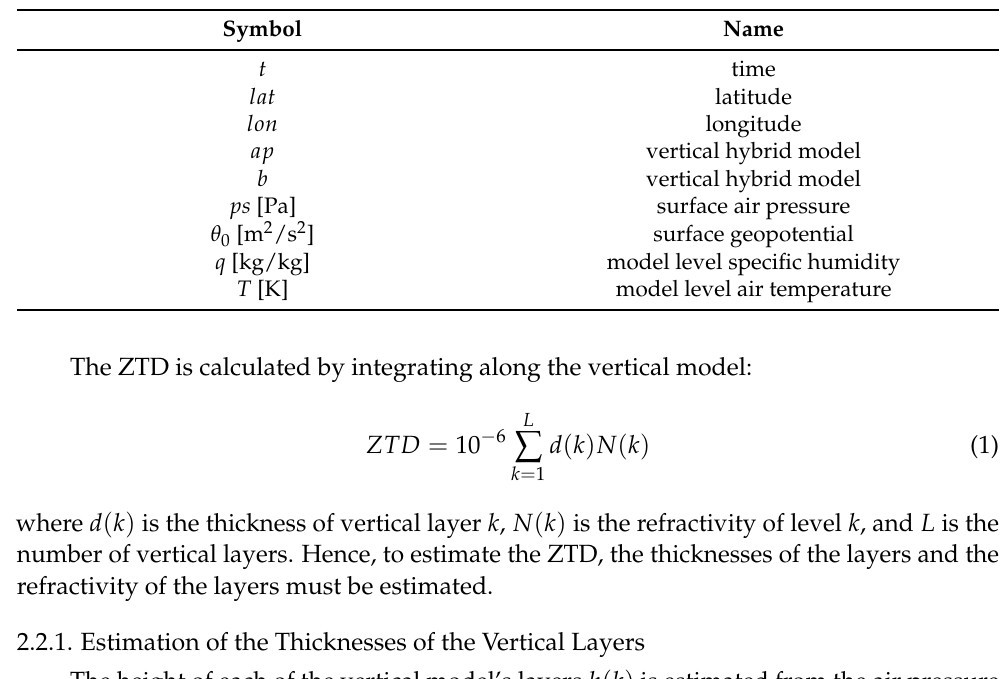
Table 1. List of meteorological